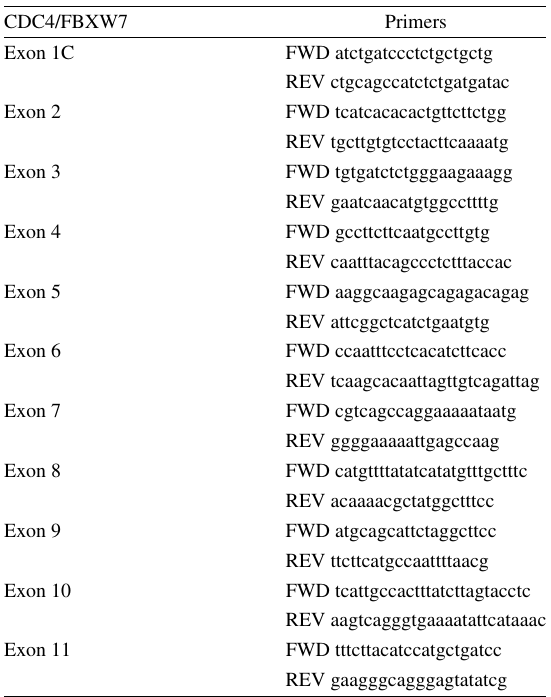
CDC4/FBXW7 primers CDC4/FBXW7